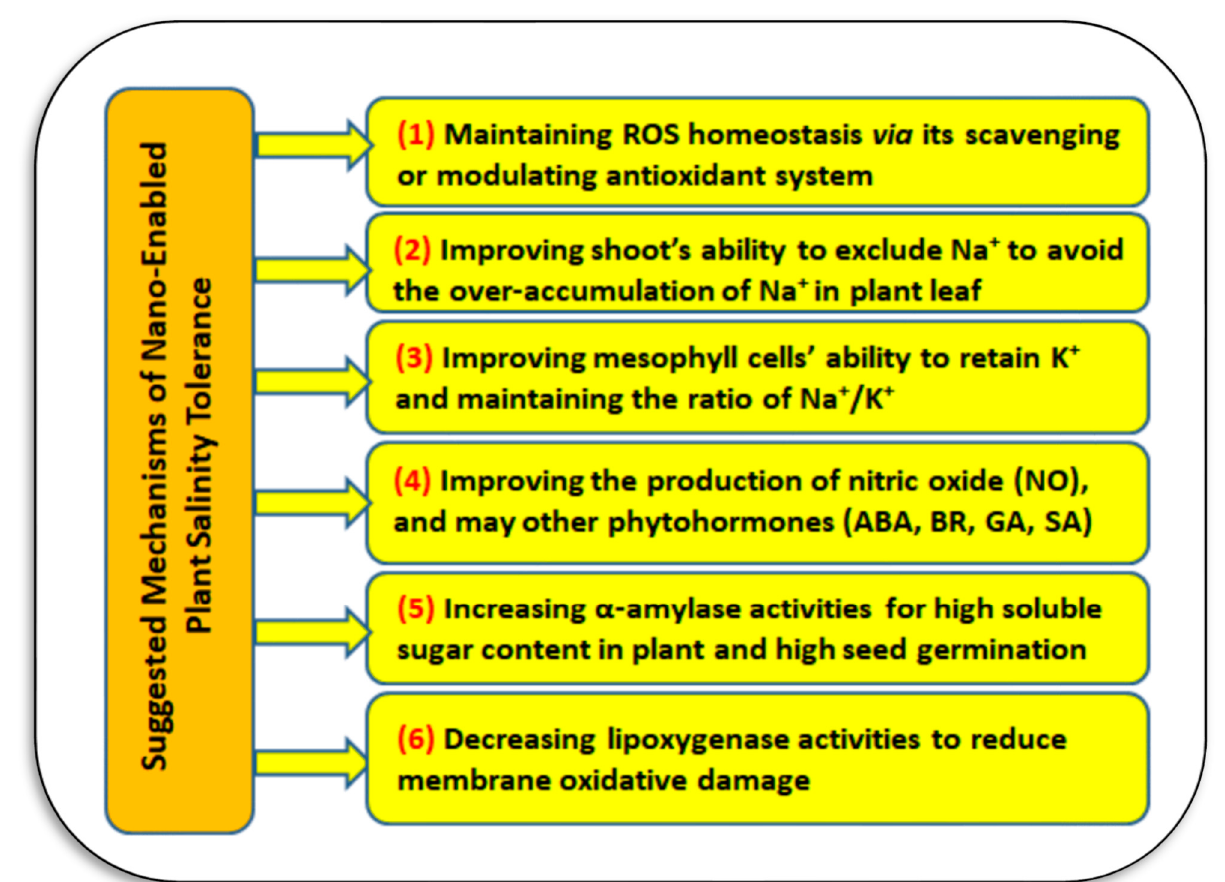
Figure 20. The suggested mechanisms of applied nanomaterials that may improve plant salinity tolerance depending on the kind of nanomaterials, the applied concentration, and plant species ( Sources: [100,146–148]). Abbreviations: Reactive oxygen species (ROS), Abscisic acid (ABA), brassinosteroids (BR), gibberellin (GA), and salicylic acid (SA).